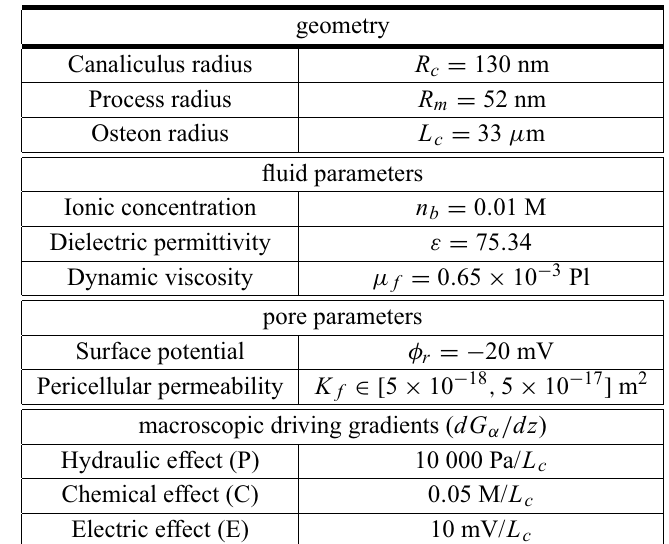
Parameters of the